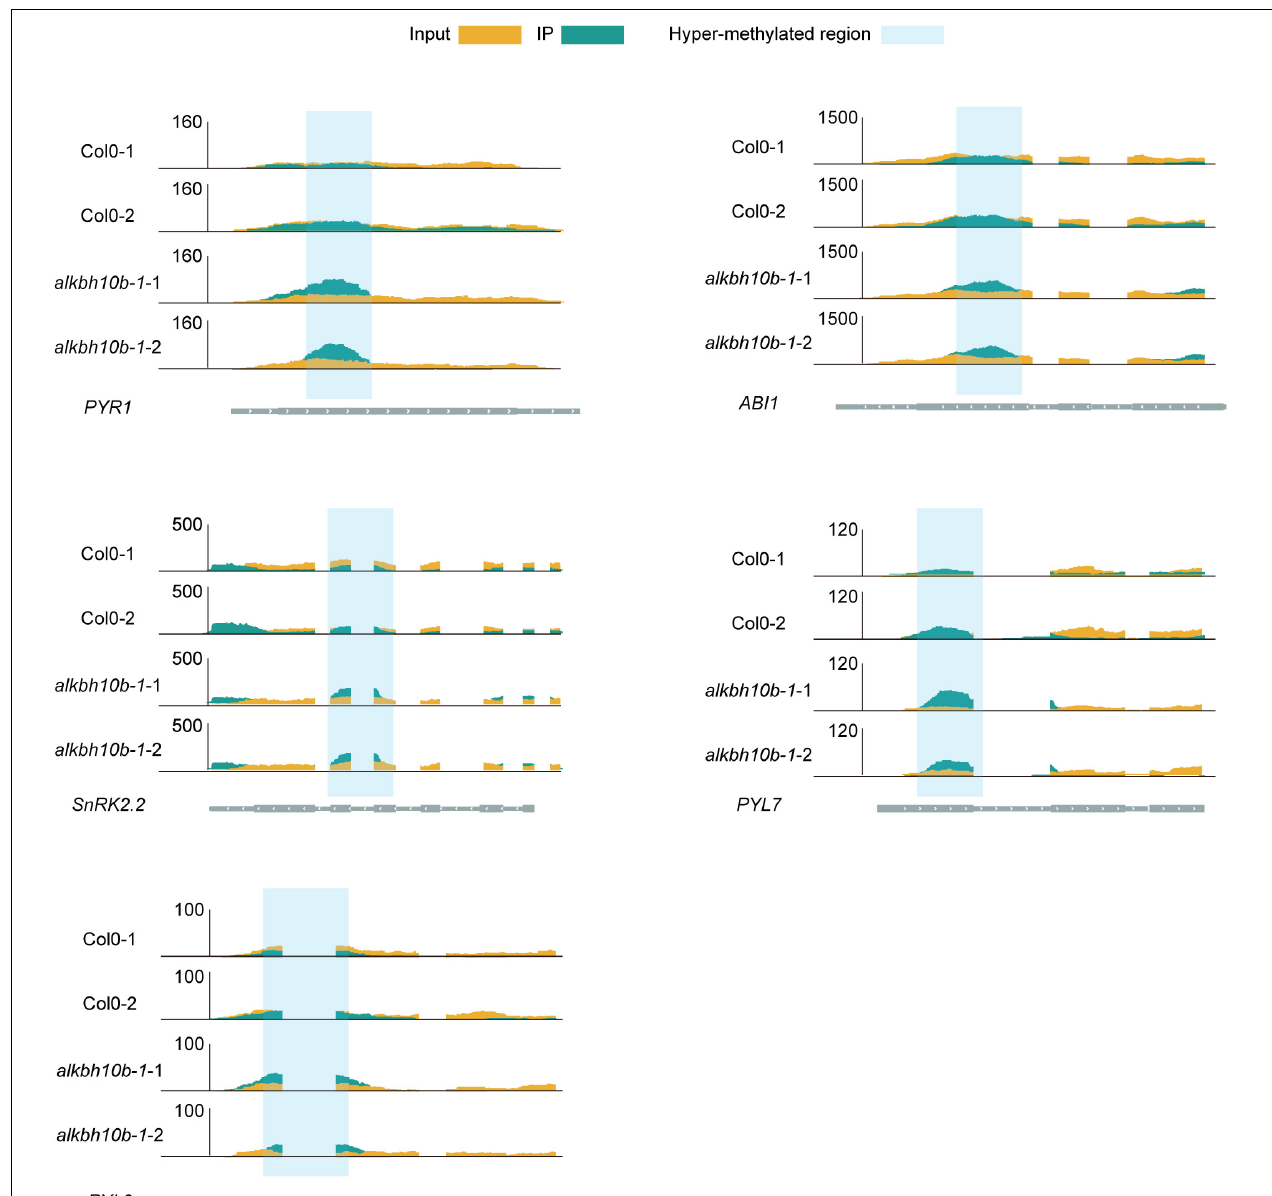
FIGURE 7 | Integrative genomics viewer (IGV) tracks showing the hypermethylated m 6 A peaks of several ABA signaling genes identified in alkbh10b-1